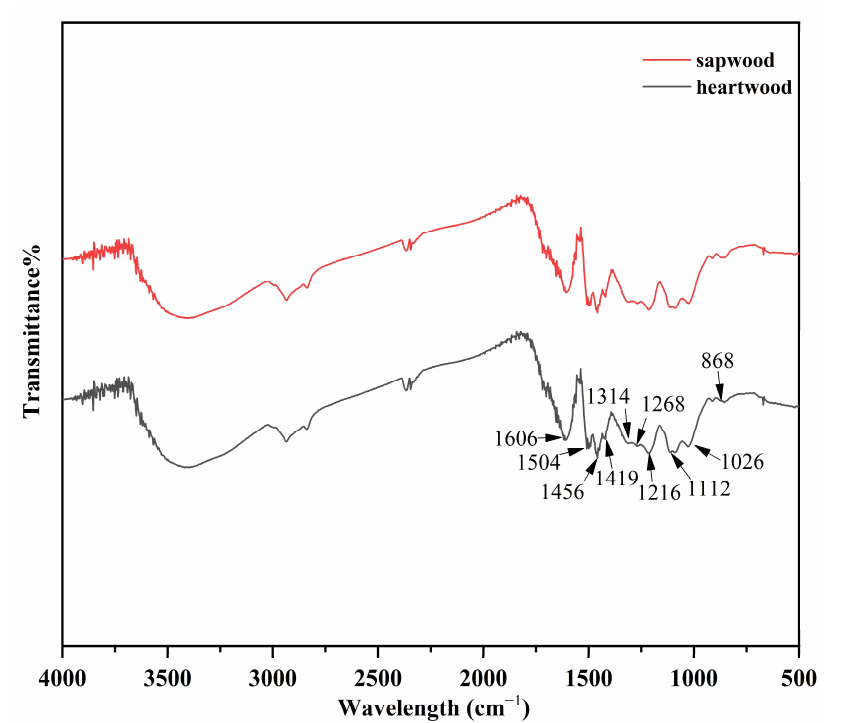
Figure 1. Infrared spectrum of Klason lignin of D. oliveri.